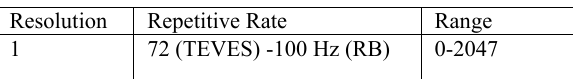
Table 2. Specification of the distance pulse sensor